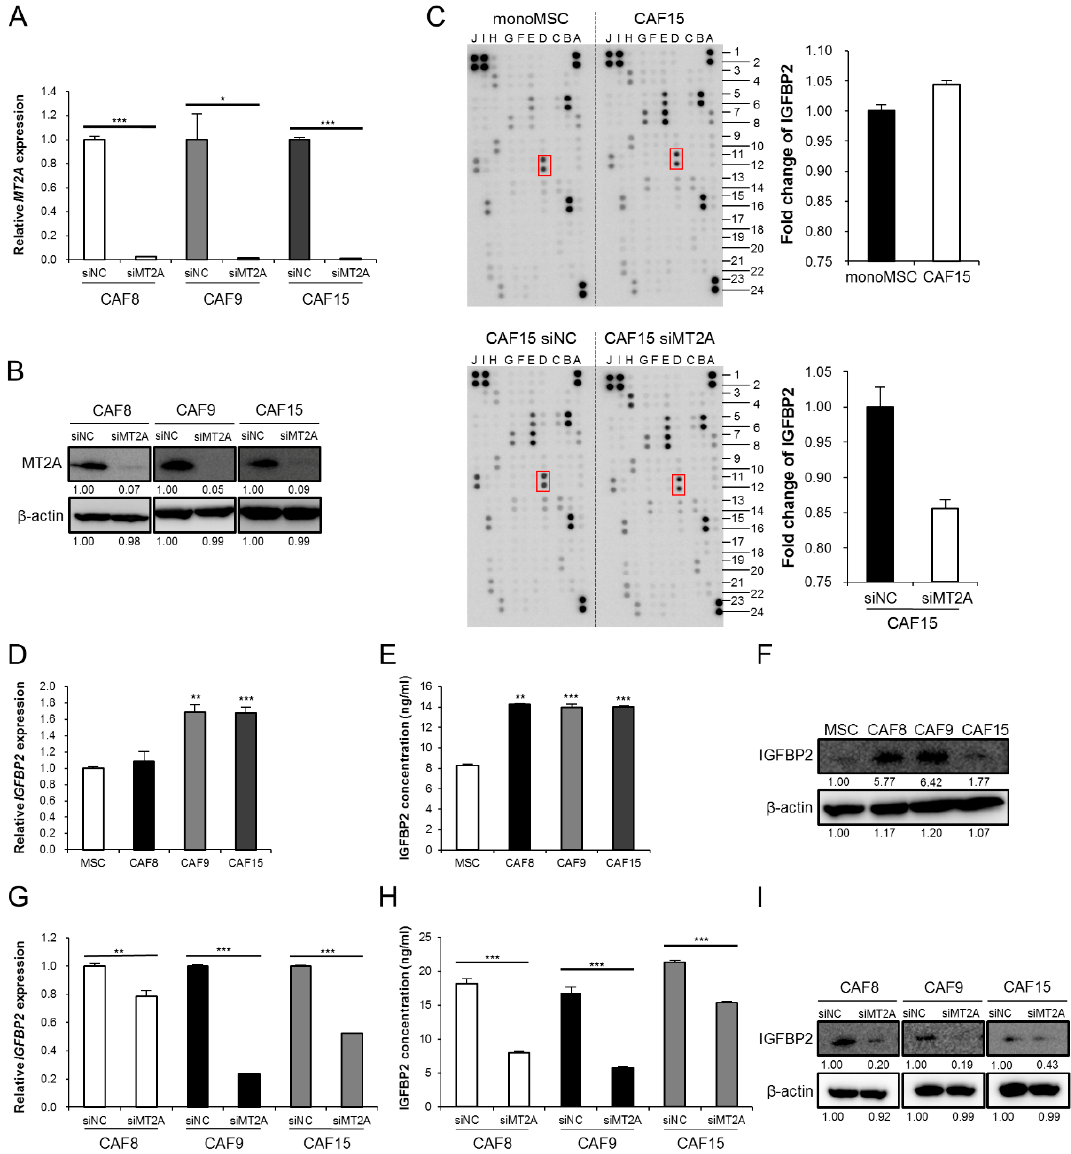
Figure 2. MT2A promotes the expression and secretion of IGFBP2 in CAF-like cells. ( A , B ) Three types of CAF-like cells (CAF8. CAF9, and CAF15) were transfected with siRNA targeting MT2A (siMT2A) and control siRNA (siNC). The knockdown was confirmed by qRT-PCR ( A ) and Western blotting ( B ). After Western blotting, the normalized relative expression fold-change was calculated using the ImageJ software, and the values were arbitrarily set as 1.00 for cells transfected with siNC. ( C ) Antibody array with monocultured MSC (monoMSC), CAF15, siNC-transfected CAF15 and siMT2A-transfected CAF15 conditioned medium. The intensity of insulin-like growth factor binding protein 2 (IGFBP2) was quantified using the public domain software ImageJ, normalized to a positive control reference spot. ( D – F ) Expression levels and secretory concentrations of IGFBP2 in CAF8, CAF9, and CAF15 cells were compared with those in MSCs using qRT-PCR ( D ), ELISA ( E ), and Western blotting ( F ). After Western blotting, the normalized relative expression fold-change was calculated using the ImageJ software, and the values were arbitrarily set as 1.00 for control MSCs. ( G ) Expression of IGFBP2 was detected by qRT-PCR in CAF8, CAF9, and CAF15 cells transfected with siNC and siMT2A. ( H ) The secretory concentrations of IGFBP2 were detected by ELISA in CAF8, CAF9, and CAF15 cells transfected with siNC and siMT2A. ( I ) Western blotting for IGFBP2 in CAF8, CAF9, and CAF15 cells transfected with siNC and siMT2A. After Western blotting, the normalized relative expression fold-change was calculated using the ImageJ software, and the values were arbitrarily set as 1.00 for cells transfected with siNC. Data are presented as mean ± SEM (* p < 0.05, ** p < 0.01, *** p < 0.001).